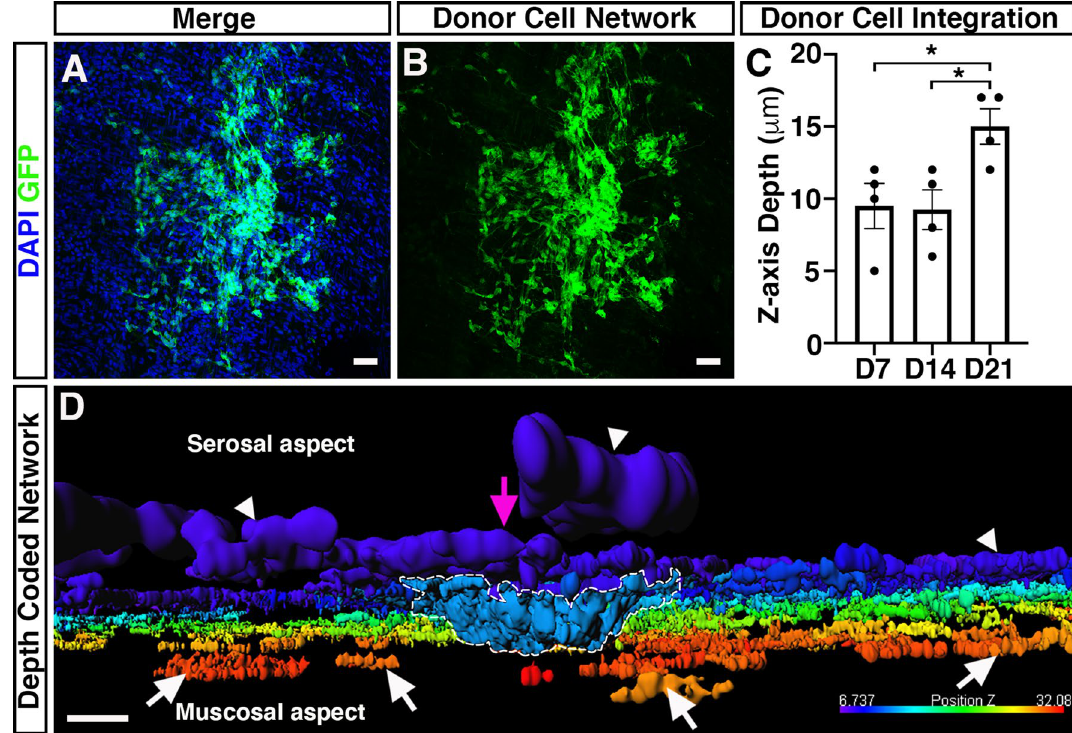
Figure 5. Integration of ENSC-derived donor cells across the gut wall. ( A , B ) Representative confocal z-stack image of donor ENSC-derived GFP + ( green ), and DAPI (blue), within the gut wall 21-days after ex vivo transplantation. ( C ) Summary data showing analysis of donor cell body (GFP + /DAPI + ) integration, measured as z-axis depth, across the gut wall at day-7 (D7), D14, and D21 after ex vivo transplantation (n = 4 for each timepoint). ( D ) Representative depth-coded image of donor cell integration at D21. Note the protrusion of donor ENSC-derived cells into the gut wall ( dashed line ) from the site of transplantation on the serosal surface ( magenta arrowhead ). Donor GFP + cells and fibres were observed to have integrated longitudinally along the gut, both on the serosal surface ( arrowheads ) and within the tunica muscularis ( arrows) . Scale bars represent 50 μm ( A , B ), 30 μm ( D ). Error bars represent mean ± s.e.m. * P ≤ 0.05, by Welch’s